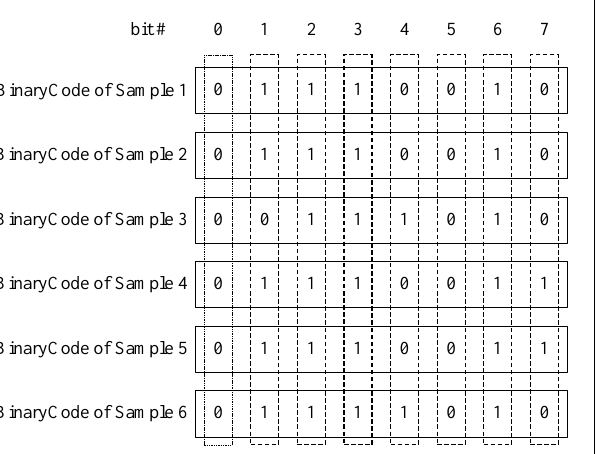
Figure 3. Examples of binary